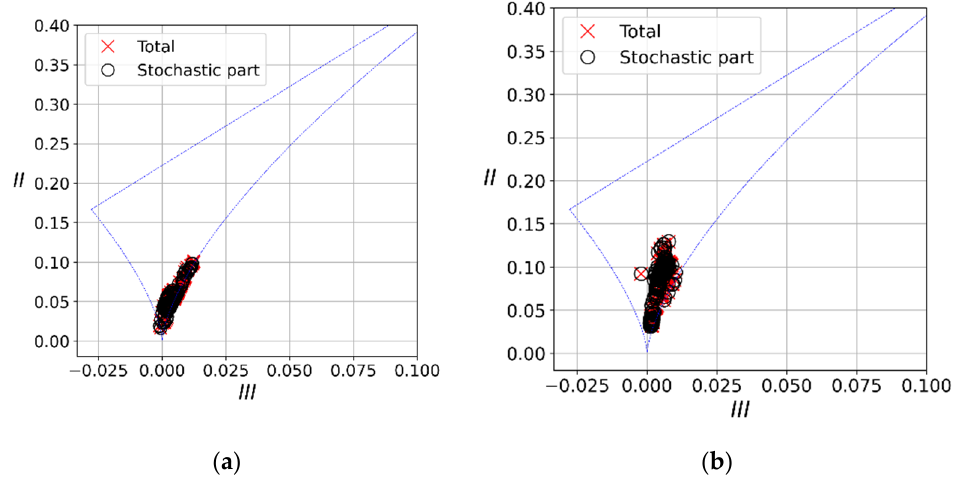
Figure 5. Turbulence anisotropy invariant map for ( a ) nonswirling and ( b ) low-swirl jets.